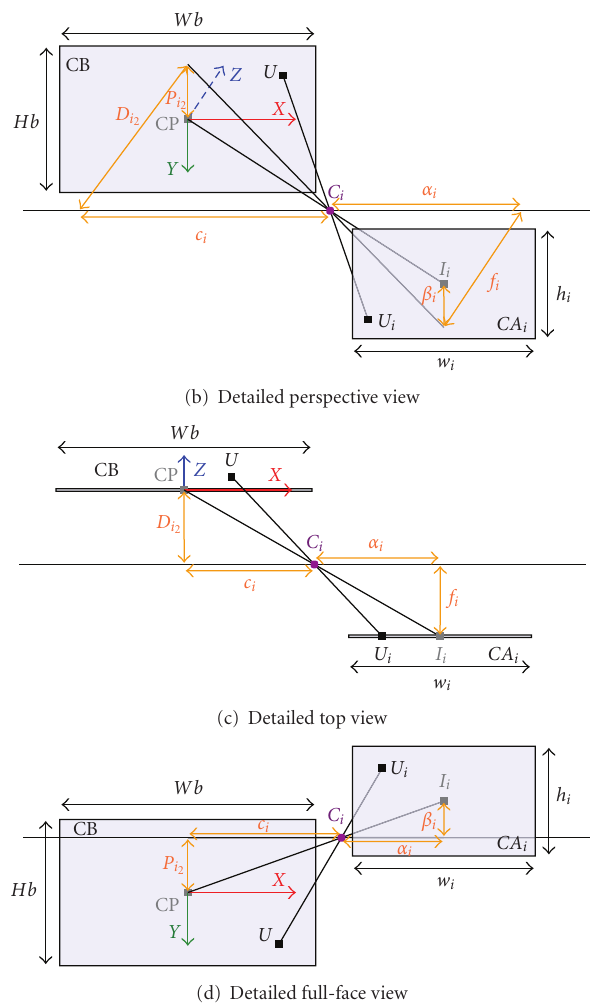
Figure 3: Implied shooting